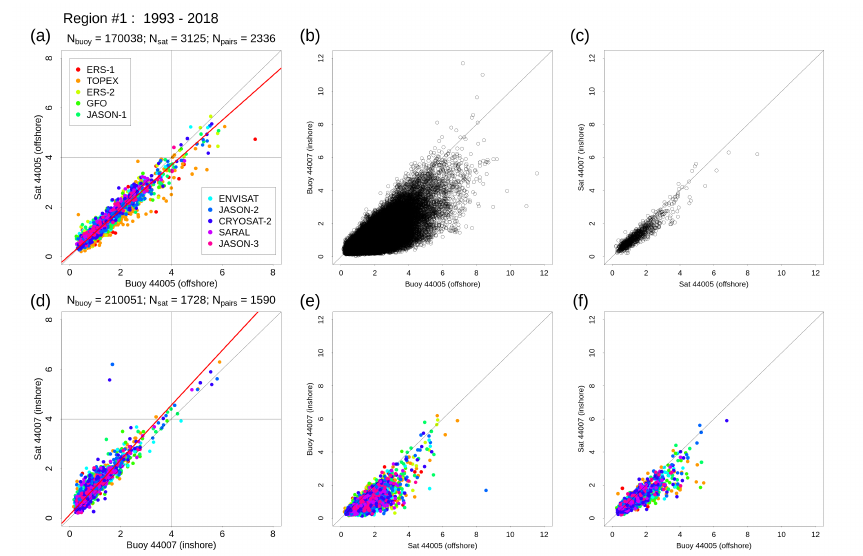
Figure 8. Scatter plots showing pairwise 1-h observations in region #1, at 44005 (offshore) and 44007 (nearshore) for combinations of source data and locations. ( a , d ) show Sea State CCI L2P vs. buoys 44005 and 44007 respectively. Red lines ( a , b ) show the fit of linear major-axis regression models to the entire data set. ( b , c , e , f ) show comparisons of the remaining combinations of source data and location. Colouring by mission is applied to selected panels where this makes sense.